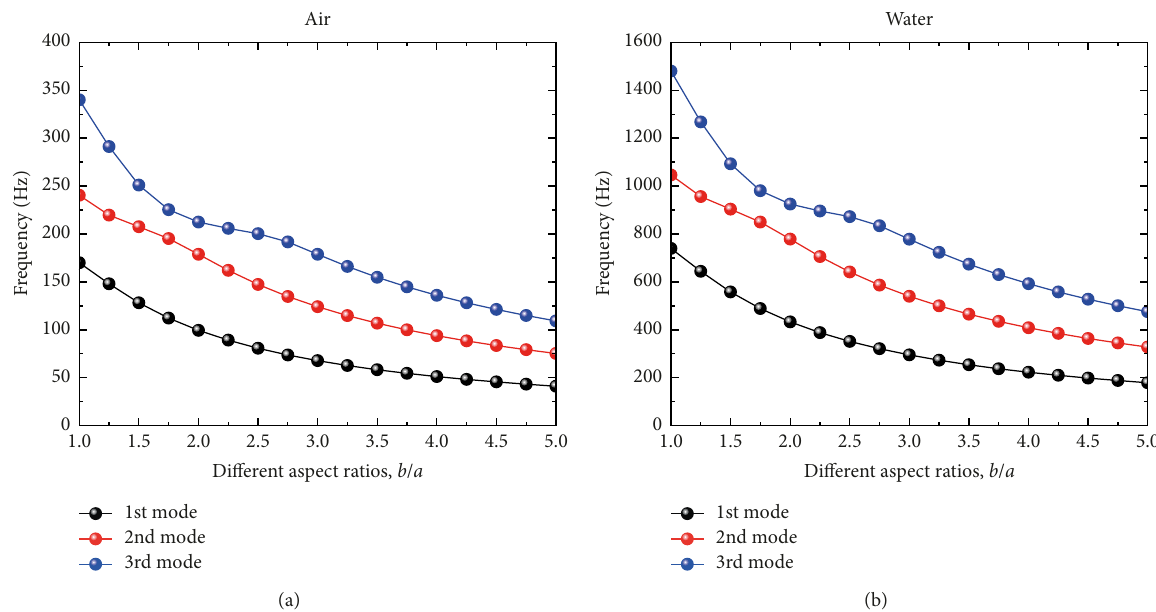
Figure 7: Variation of the frequency of the triangular prism acoustic cavity with various apex aspect ratios.